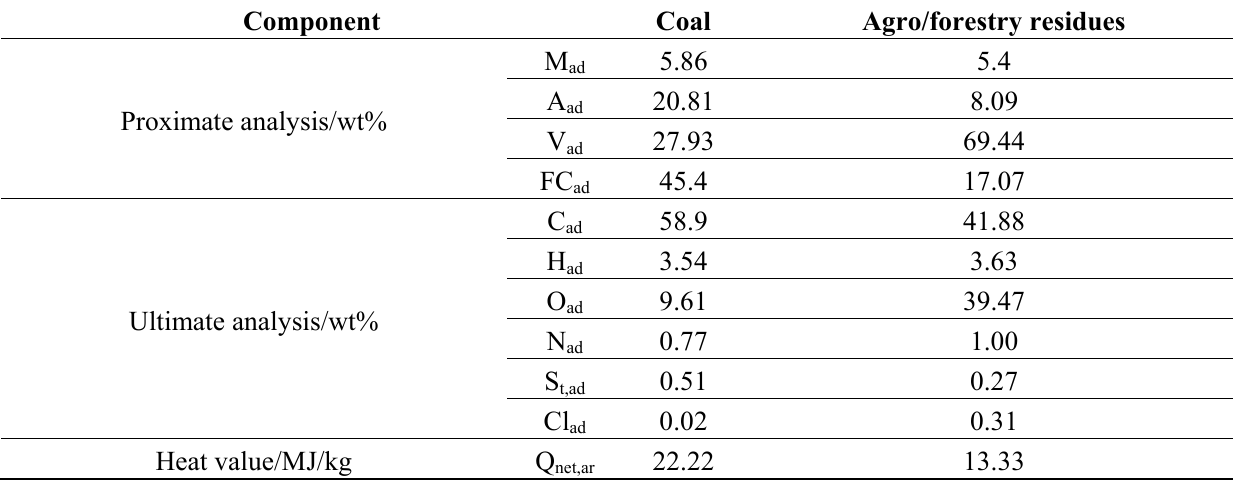
Table 1. Proximate analysis and ultimate analysis of fuels (ad: Air dried basis; ar: As received